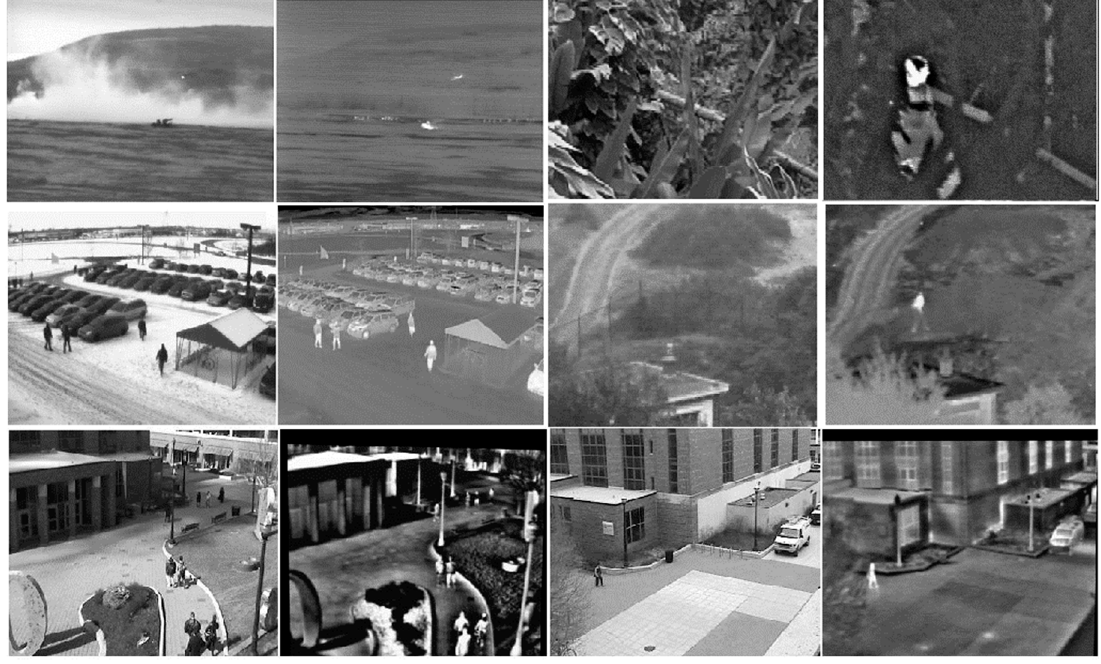
Figure 11. Database set for testing different fusion methods.